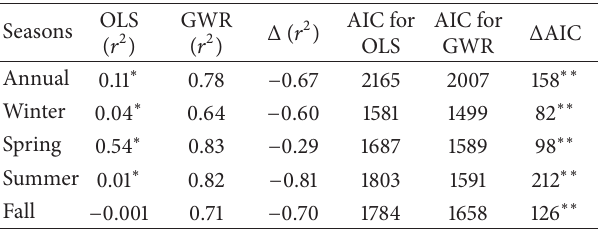
Table 1: Coefficient of determination ( 𝑟 2 ) and AICs derived by OLS and GWR